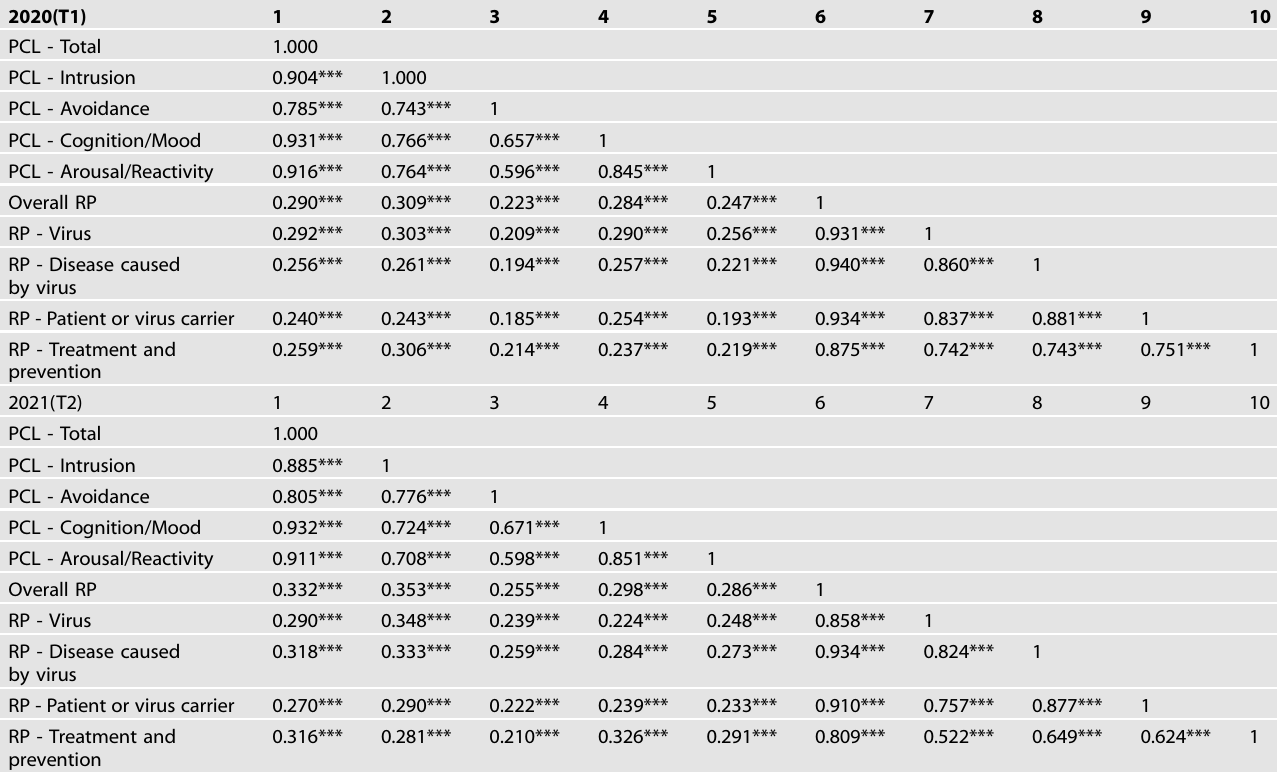
Table 1. Correlations between risk perception and PTSD in T1 and